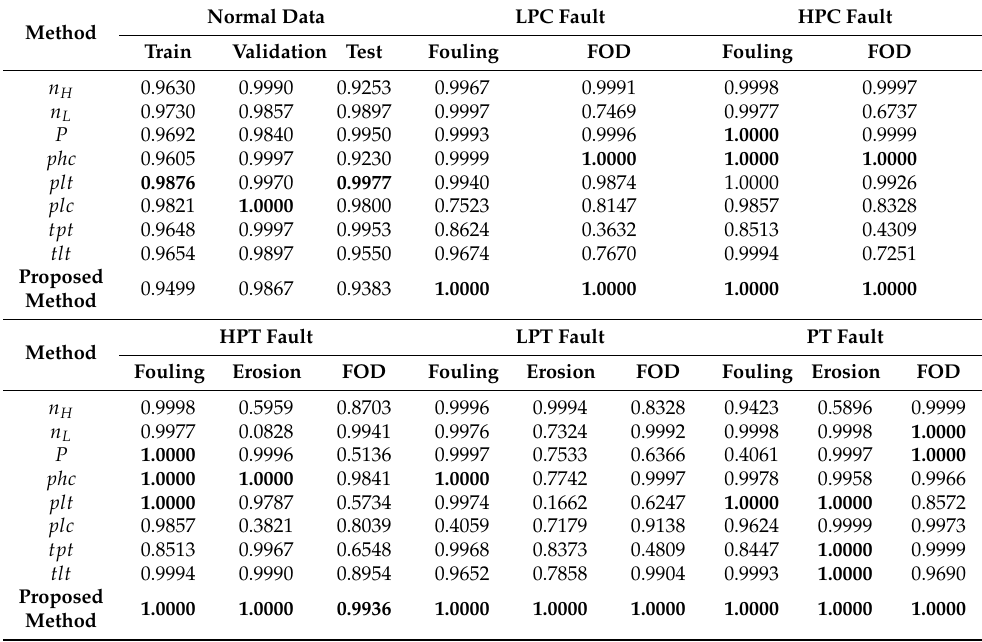
Table 6. Fault detection accuracy comparison with single normal pattern